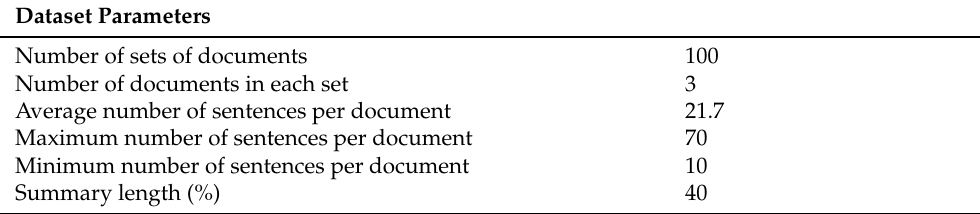
Table 5. Characteristic of the